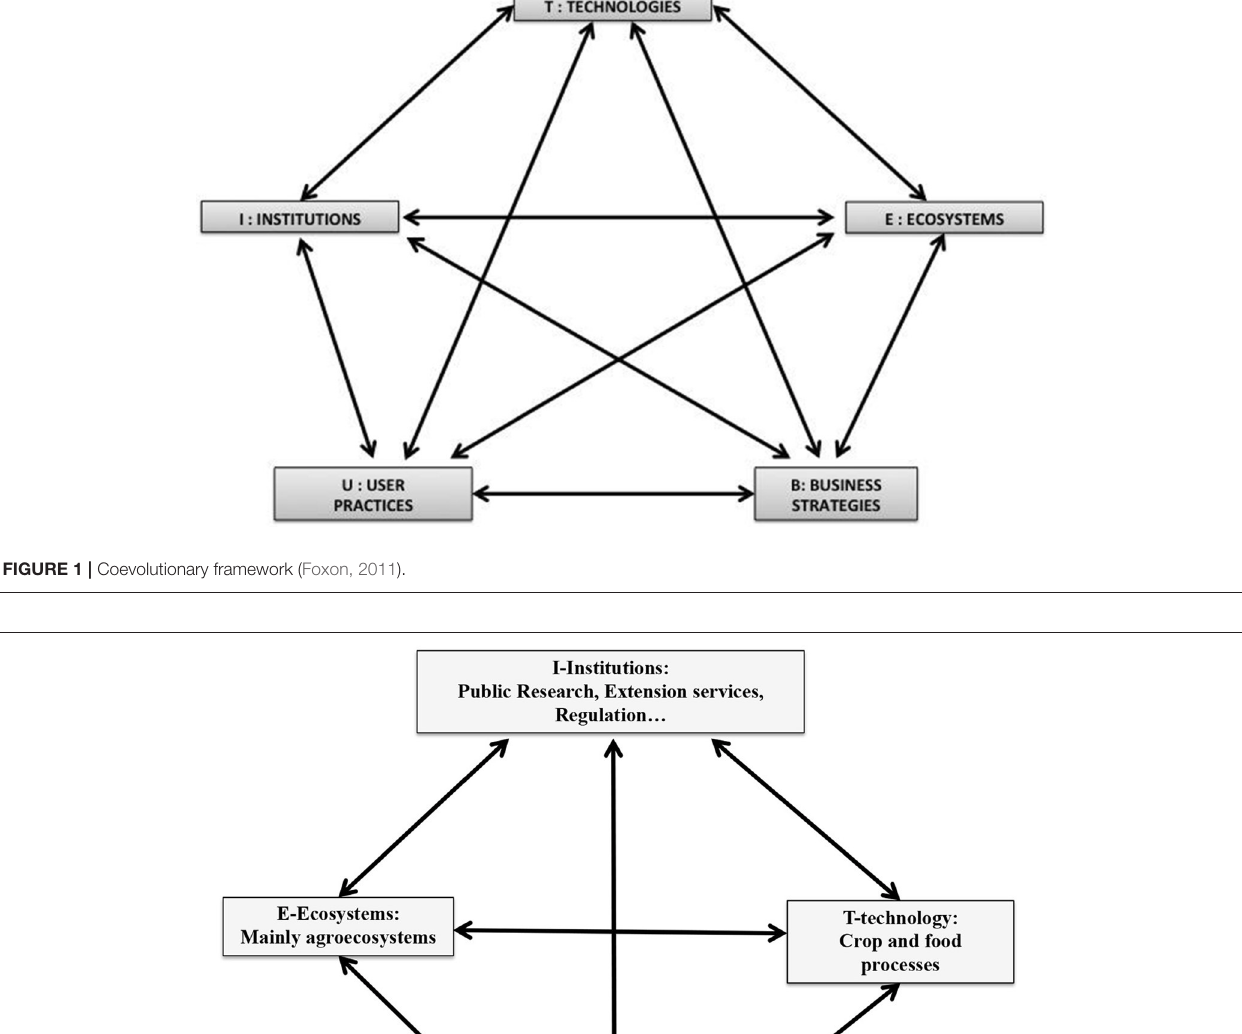
use (Weiner, 2017). Crop diversity and legumes also affect soil fertility (Gogoi et al., 2018). Finally, as nearly half of cereal production is used for animal feed, less animal-based, and